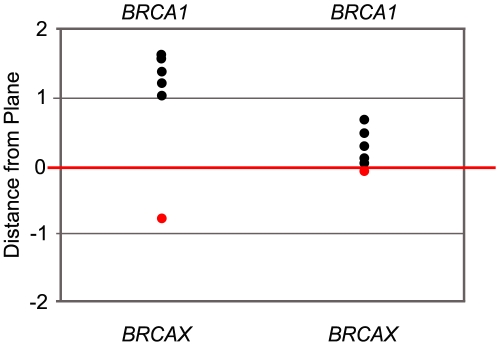
Confidence of Predictions for Missense BRCA1 LCLs as Determined by Distance from the SVM Plane.The SVM plane separating BRCA1 from BRCAX is shown by the red line. If the sample falls over the line (black point) the missense mutation is correctly predicted as pathogenic for BRCA1 mutation. If the sample falls under the line (red point) the missense mutation is incorrectly predicted as BRCAX. The gene lists used for the predictions are the top 200 genes from BRCA1 missense vs BRCAX, and the top 200 genes from BRCA1 Truncating vs BRCAX.